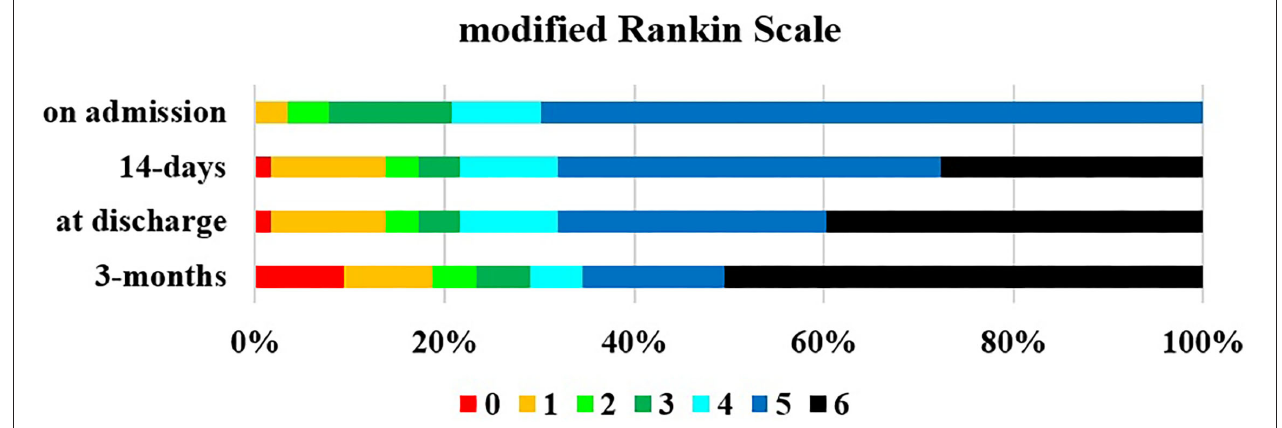
FIGURE 2 | Outcome based on mRS on admission, at 14 ± 2 days, at discharge and at 3 months ± 7 days. Mean discharge time was 19.8 days (minimum 1 days, maximum 79